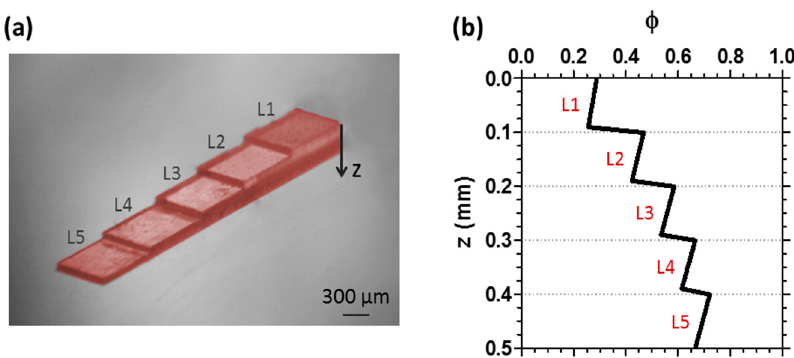
Figure 7. ( a ) Example of a UV cured sample made of coloured diacrylate, printed by setting 100 µ m as single layer thickness; ( b ) profile of the step-gradient conversion φ along the sample depth z , modelled using the optical attenuation coefficient of the system ( µ = 1.54 mm − 1 ).